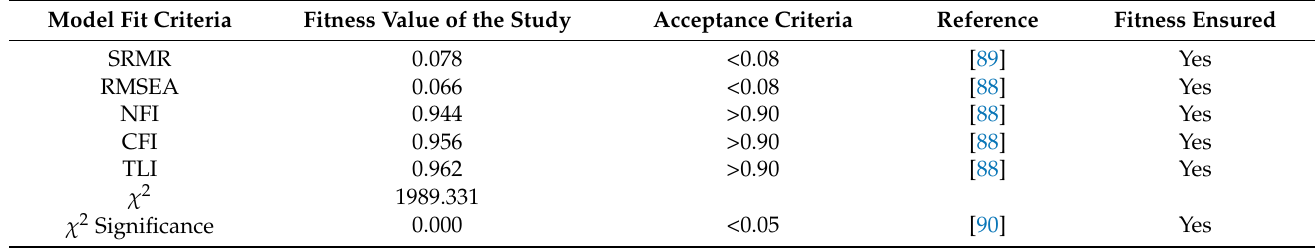
Table 3. Model fitness